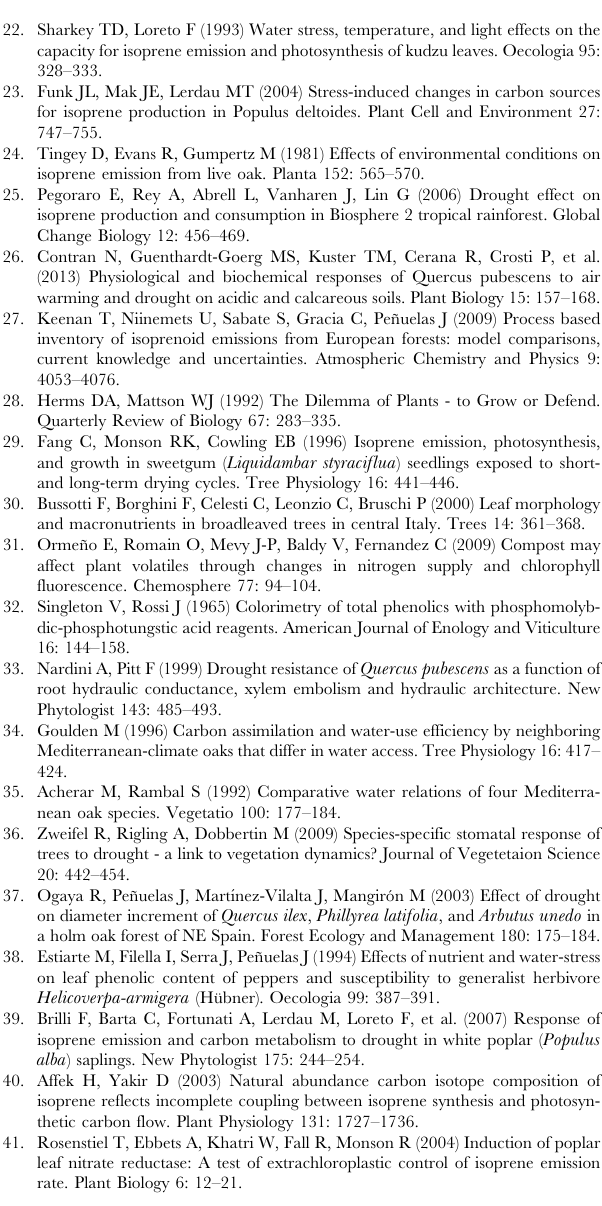
Figure S2 Balance between growth and carbon-based secondary metabolism. Response of carbon-based secondary constitutive metabolites, growth and net photosynthesis to resource availability as stated by the Growth Differentiation Balance Hypothesis (graph A) and as observed for isoprene emissions in this research study (graph